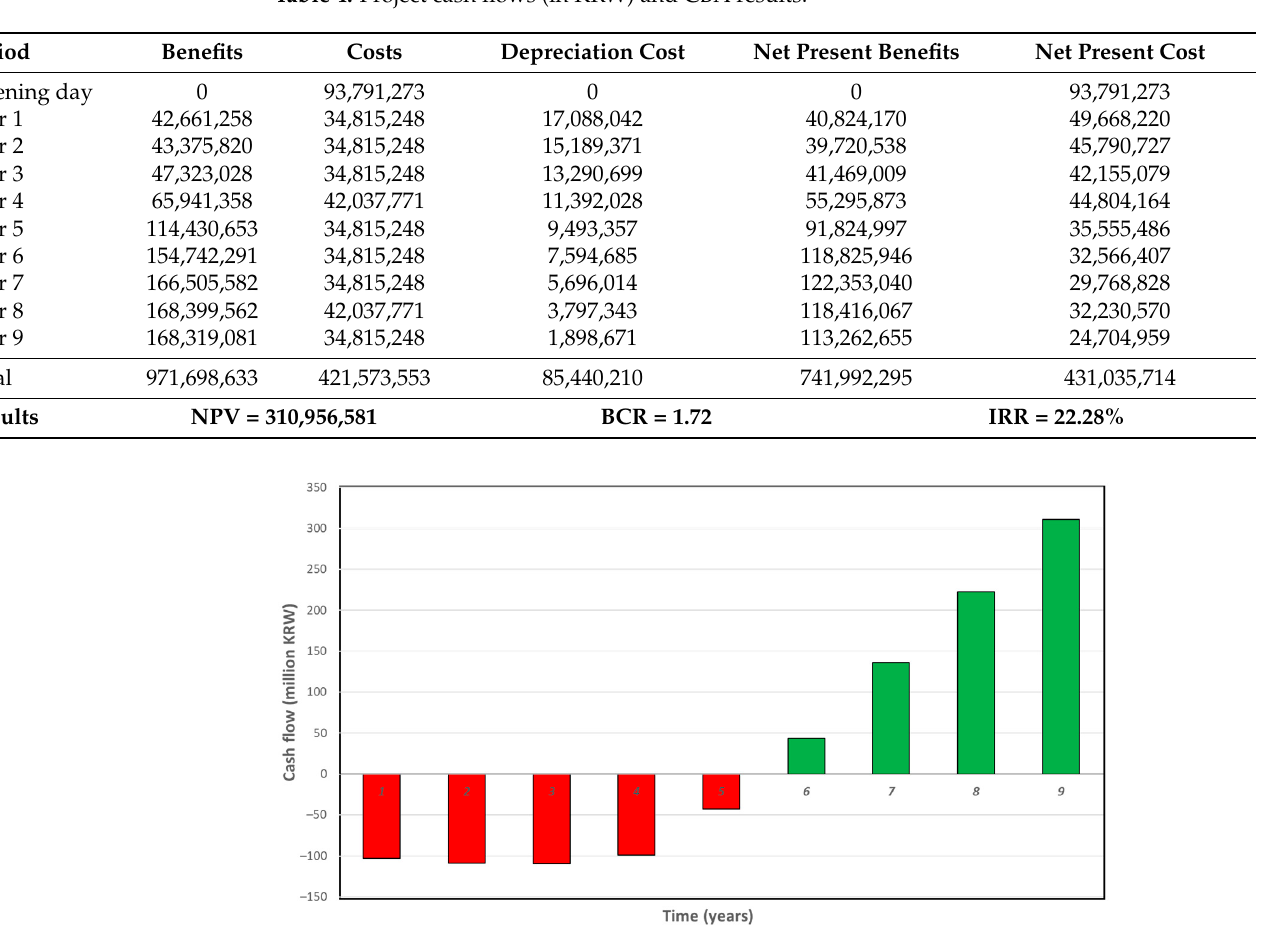
Table 4. Project cash flows (in KRW) and CBA results.